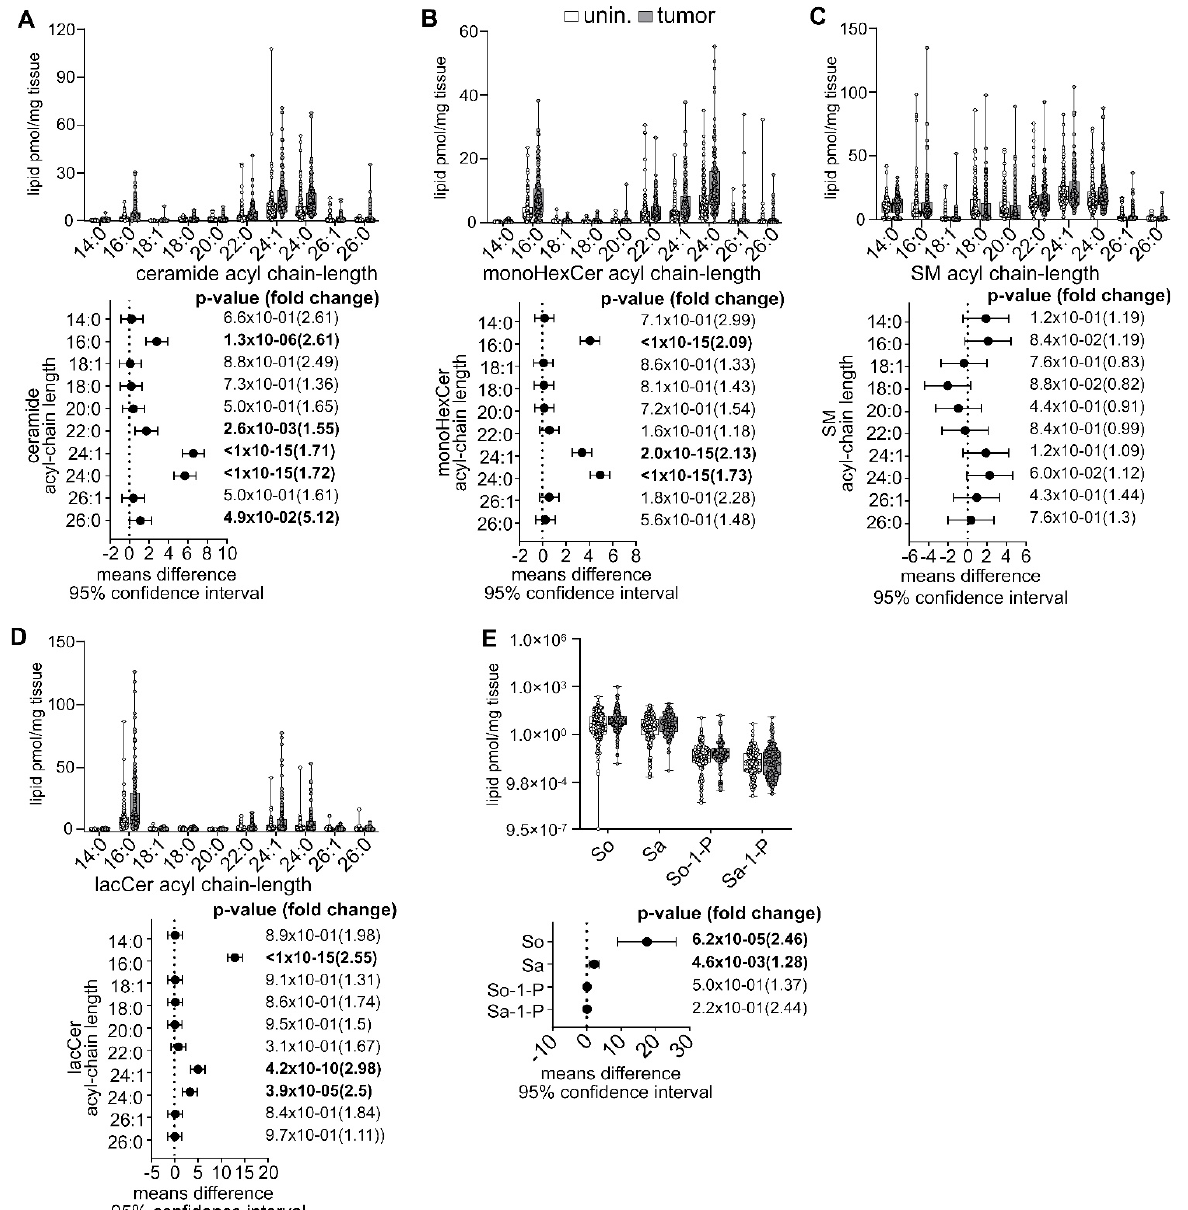
Figure 9. Race-independent pan-cancer analysis of alterations in tumors of subjects with LUAD, COAD, HCC, EEC, and HNSCC. Data from AA and NHW presented in Figures 2 and 3 were pooled by sphingolipid class and acyl chain length and analyzed to examine pan-cancer alterations in human cancers. In each panel ( A – E ), the upper graphs are box plots showing medians (black line) and whiskers of min to max (top), and the bottom graphs are plots of the 95% family-wise significance and confidence intervals for predicted means difference calculated following ANOVA. The mean fold-change between unin. tissue and tumor was calculated by dividing the mean lipid level in tumors by the mean lipid level in unin. tissues and shown between parenthesis next to the corresponding unadjusted p -values (Fisher’s LSD; Prism). The lower limit of p - and q-value calculations was set to 1.0 × 10 -15 (Prism), so no values are reported lower than this limit. For p -adjusted (q) values corrected for multiple comparisons using the FDR (Q = 0.05) and the two-step controlling procedure of BKY, see Supplementary Table S21. For panel ( E ), the y -axis is in log2 scale. Alterations considered significant ( α ≤ 0.05) are in bold text.